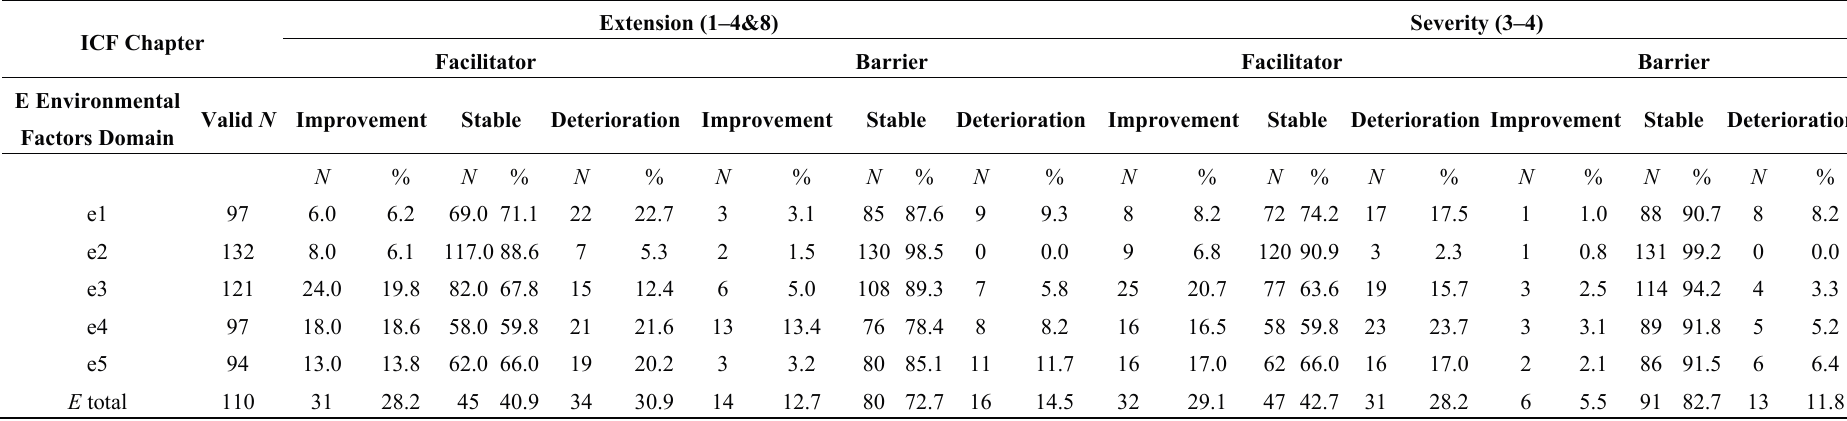
Table 5. Number and percentage of patients who improved, remained stable, or deteriorated with respect to the number of facilitators and barriers (extension and severity indexes) on the various chapters within the Environmental Factors